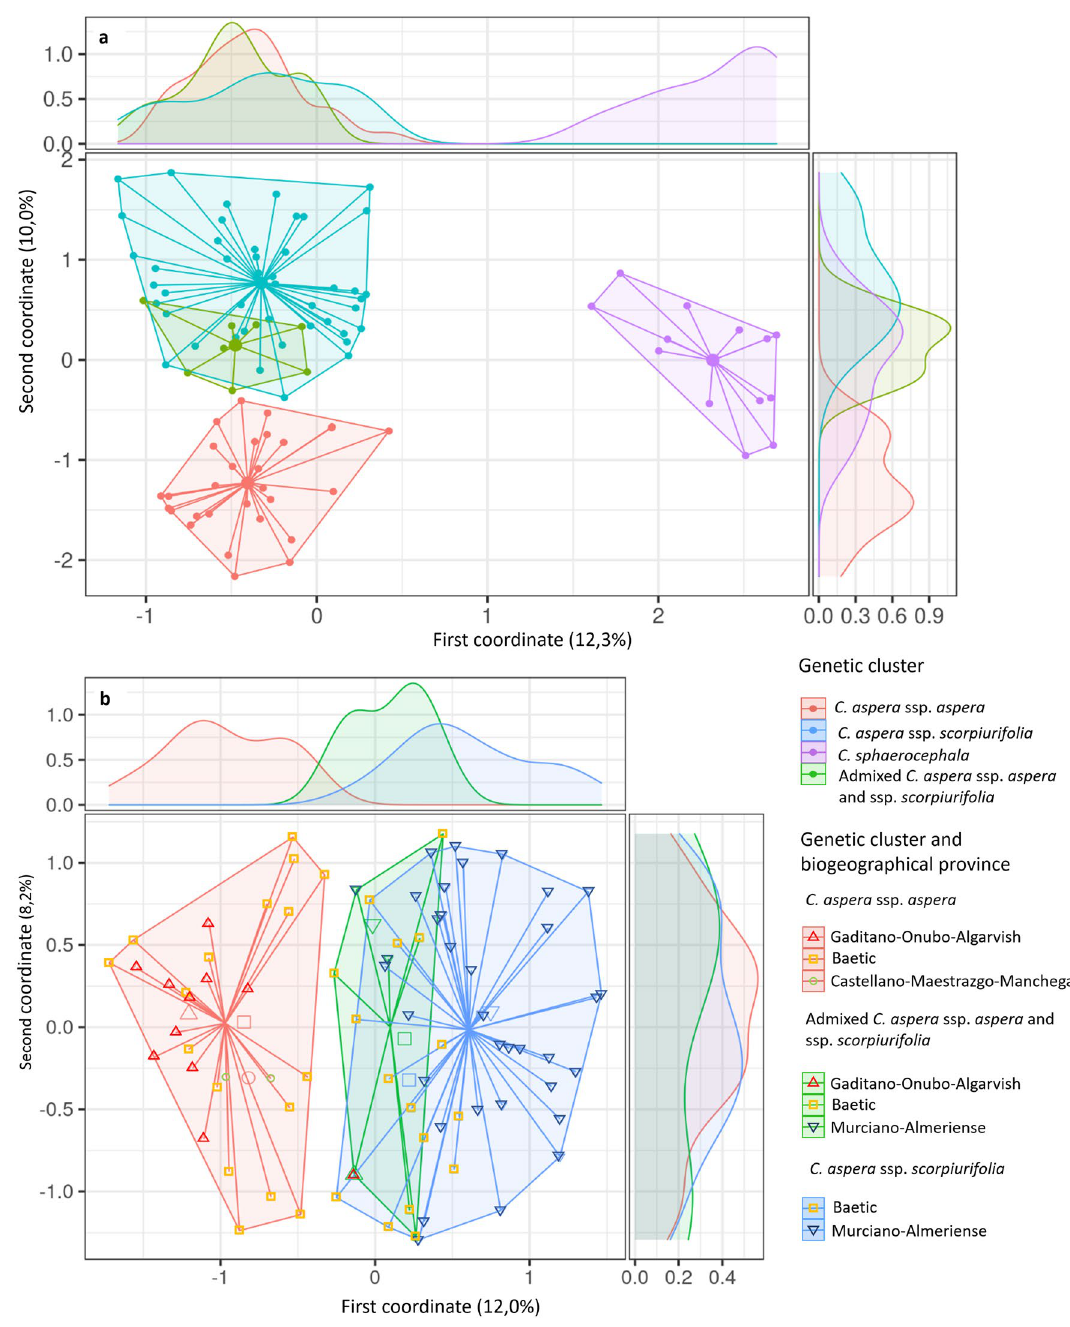
Figure 3. Principal Coordinates Analysis of Centaurea individuals of the Seridia section found in Andalusia, based on the genetic clusters detected using STRU CTU RE. The percentage of the total variance accounted by each axis is shown in brackets. The densities of individuals within each cluster along the two axes are represented. ( a ) Ninety-five individuals ( C. sphaerocephala , ssp. aspera cluster, C. aspera ssp. scorpiurifolia, and admixed individuals between the two latter). ( b ) Eighty-two individuals (ssp. aspera cluster, ssp. scorpiurifolia, and admixed individuals between them). Locations of the individuals according to biogeographical provinces are